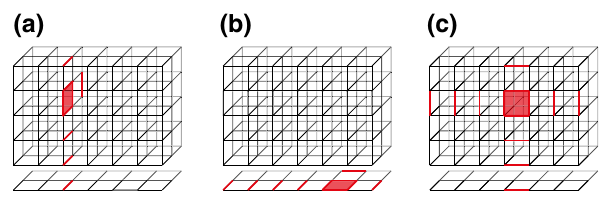
FIG. 7. X stabilizers on the lattice described in Fig. 6. (a) X stabilizer corresponding to the transversal-vertical square indexed by (α , β , k ) = ( 1, 2, 3 ) ; its support is contained in the cross of transversal and vertical qubits (red edges) in the y - z plane { x = 3 } . The crossing has coordinates ( z , y , x ) = ( 1.5, 2.5, 3 ) and sits in the center of the red square. (b) X stabi-